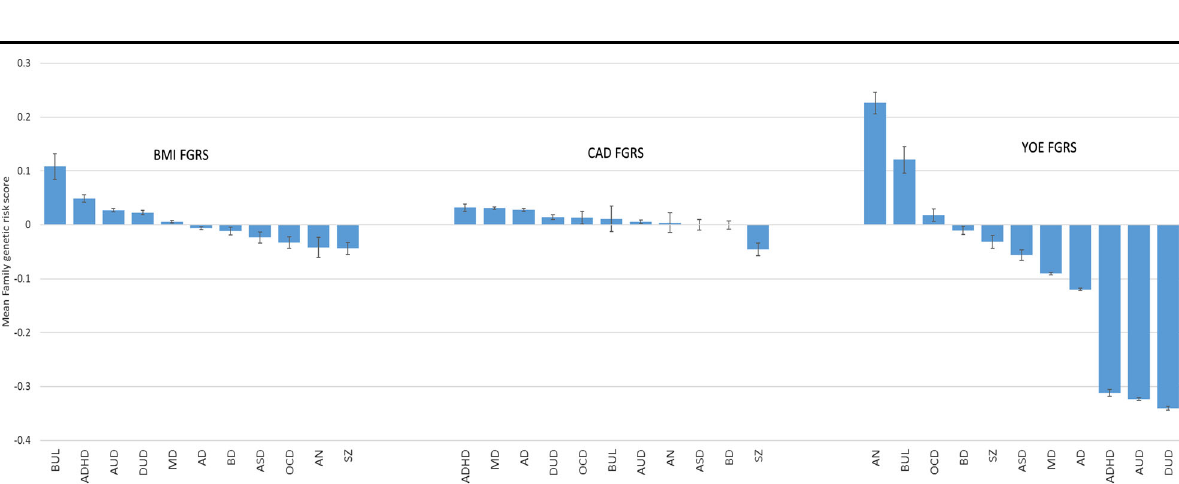
Fig. 3 Validation of the FGRS Scores. The mean genetic risk score for body mass index (BMI), coronary artery disease (CAD), and years of education (YOE) in 11 disorders ascertained from the general Swedish population. The y -axis is the mean z -score for the genetic risk scores. The disorders are ranked from highest to lowest score.